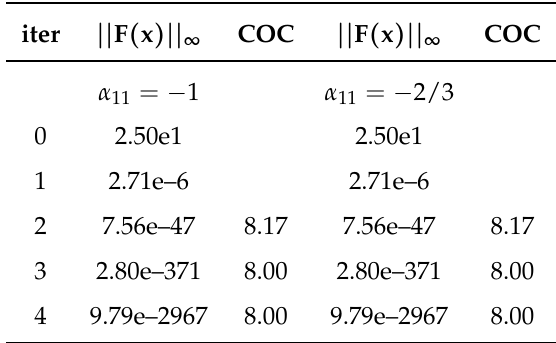
Computational convergence order of iterative method Equation (5), initial guess = [ 0.5,0.5,0.5, − 0.25 ]